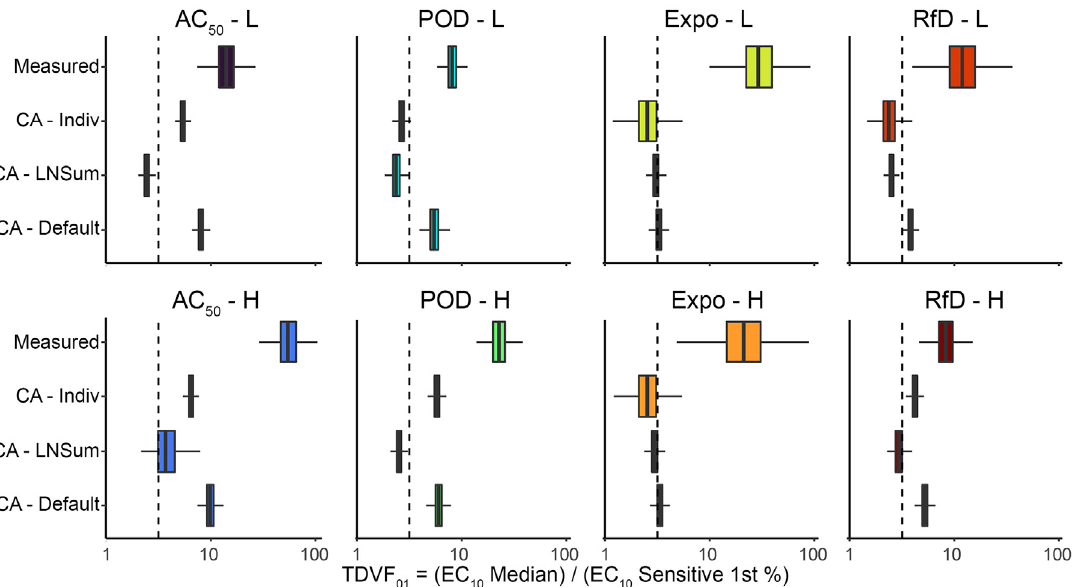
Figure 5. Comparison of toxicodynamic variability factor covering the sensitive (1st percentile) individual (TDVF 01 ) measured and predicted by different concentration addition (CA) approaches. See Section 2 and Figure 1 for details as to different CA approaches CA Indiv , CA LNSum , CA Default . Vertical dashed line indicates the default uncertainty factor for toxicodynamic variability UF H,TD = 10 ½ .